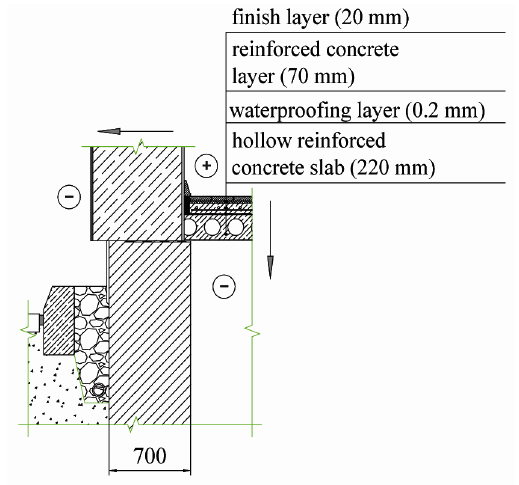
. Fig. 3 Vertical section of the cellar ceiling before renovation.